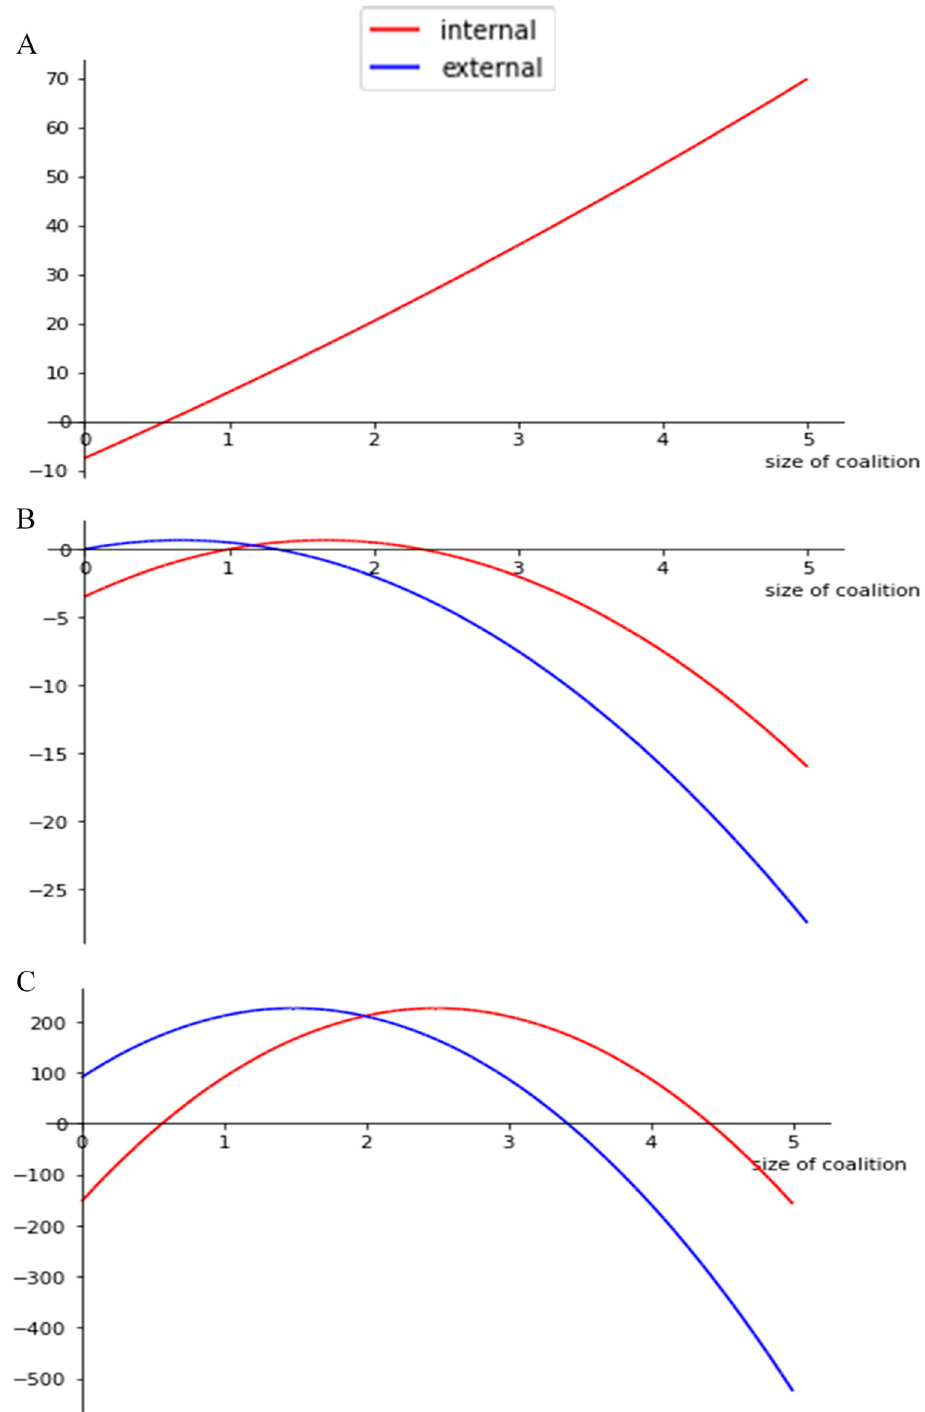
Figure 1. Graphs of stability conditions. ( A ) Grand coalition is stable, ( B ) Coalition of size 2 is stable, ( C ) Coalition of size 4 is stable.